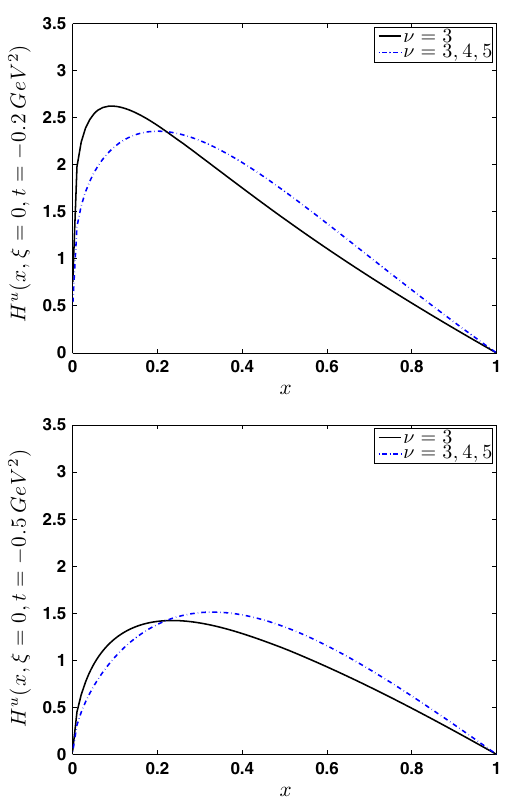
the ν = 3and ν = 3 , 4 ,